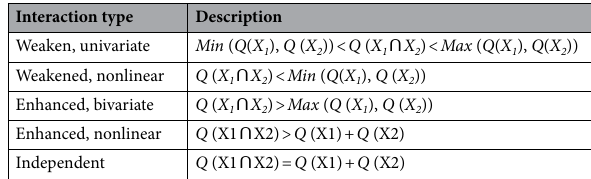
Table 2. Categories of interactive relationships between two factors.